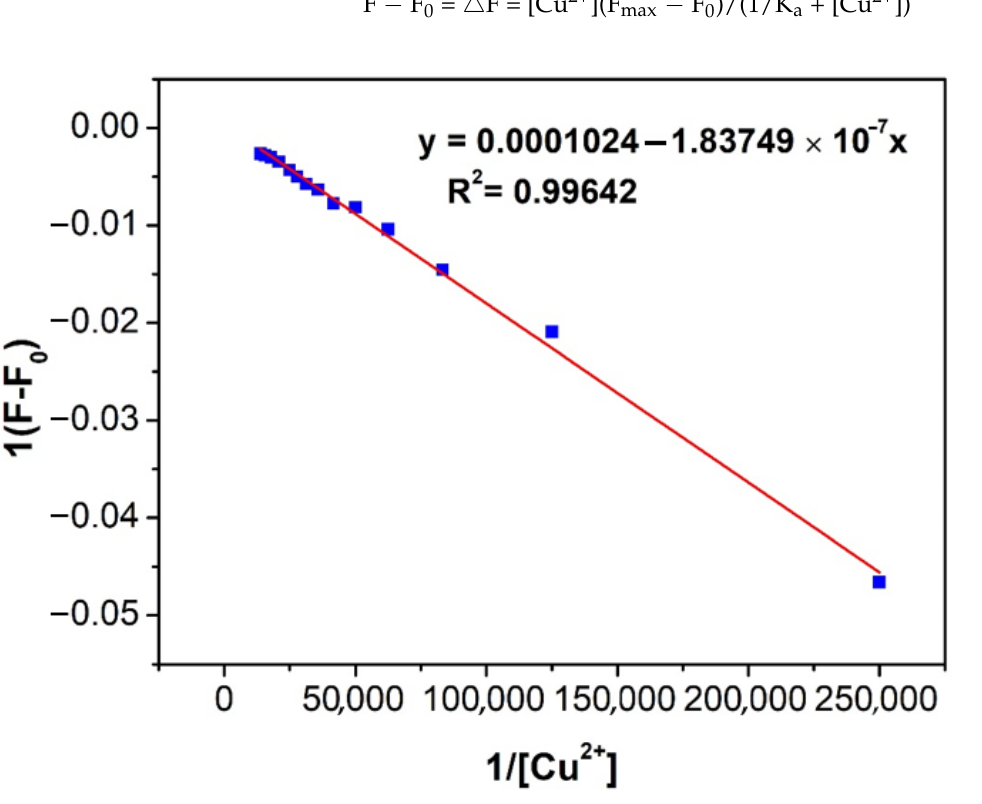
Figure 6. The Benesi–Hildebrand plot of 1/(F − F 0 ) versus 1/[Cu 2+